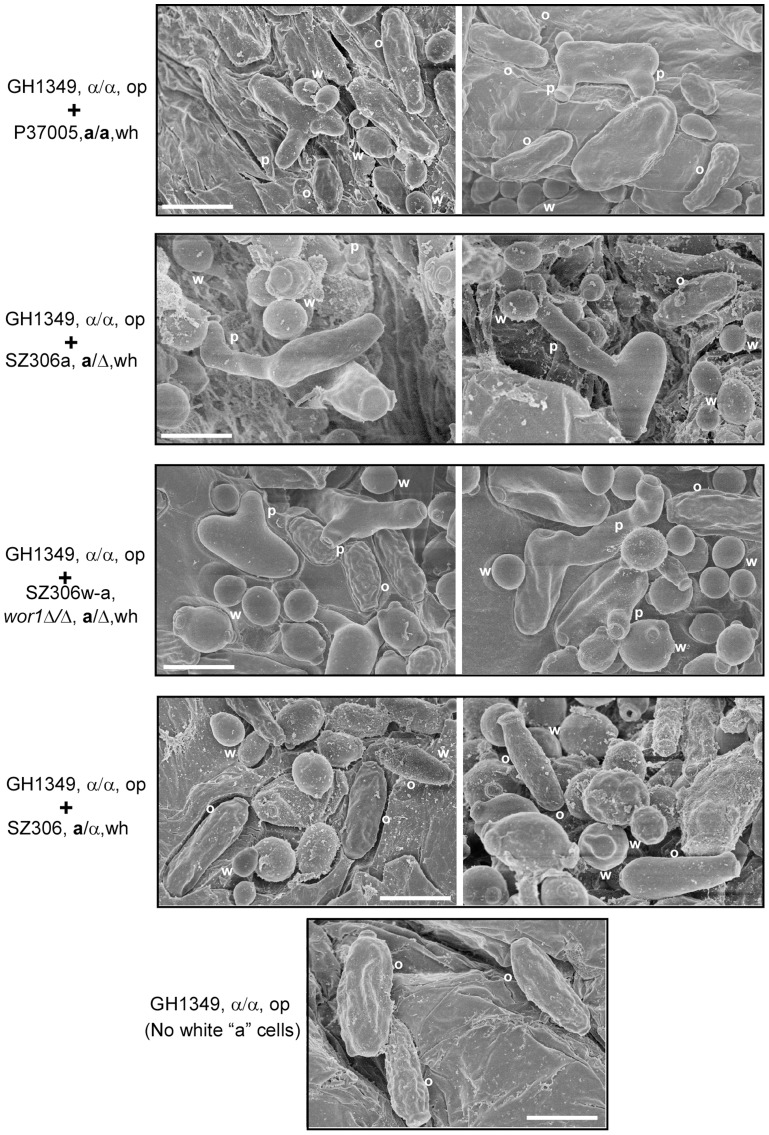
White a cells induce mating projection formation in opaque α cells in a mouse skin infection model.1×107 opaque α cells (GH1349) and 1×107 white “helper” cells were mixed and spotted onto the skin of newborn mice for infection. The wor1Δ/Δ mutant (SZ306w-a), WT “a” (P37005 and SZ306a) and “a/α” strains (SZ306) were used for induction of mating projections. Opaque α cells (GH1349) alone (no white “helper” control) was used as a control. Representative SEM images are shown. W, white cells; O, opaque cells; P, mating projections. Scale bar, 10 µm.